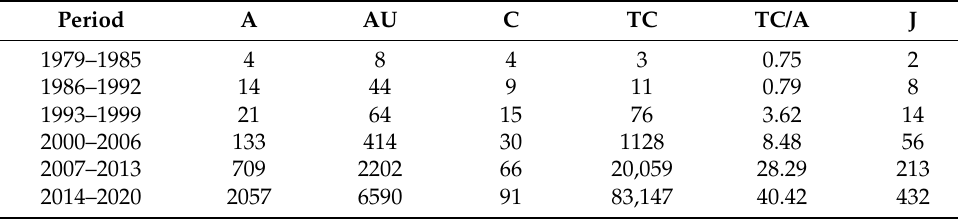
Table 3. Removal of pharmaceuticals from wastewater (RPW): major